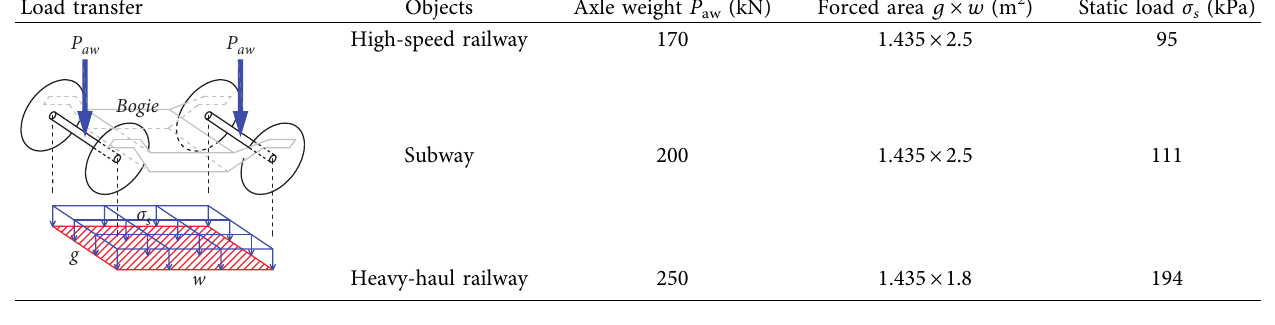
Table 3: Determination of static load σ